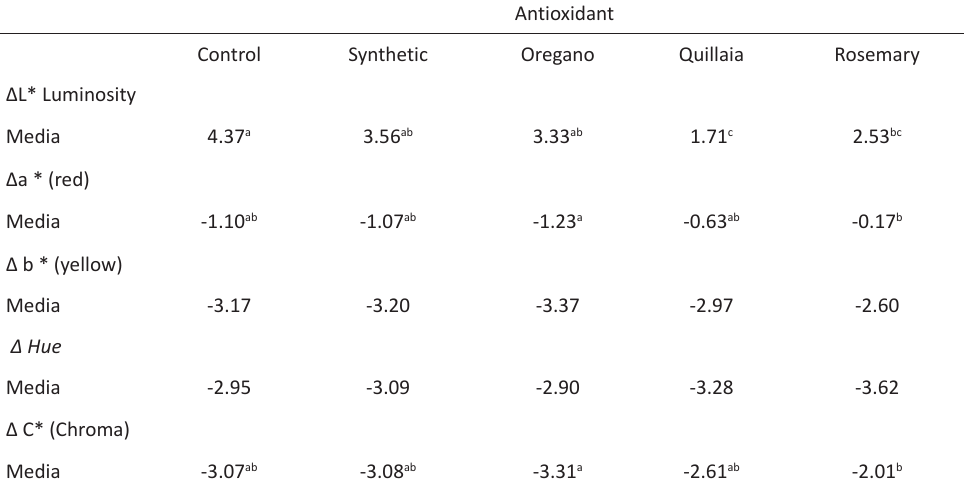
Table 4. Values L, a *, b *, Hue, Chroma, in rainbow trout fillets ( Orcorhynchus mykiss ) marinated with different antioxidants in equivalent dose (4% absorption), and subsequent cooling between 0 and 12 days Antioxidant Control Synthetic Oregano Quillaia Rosemary